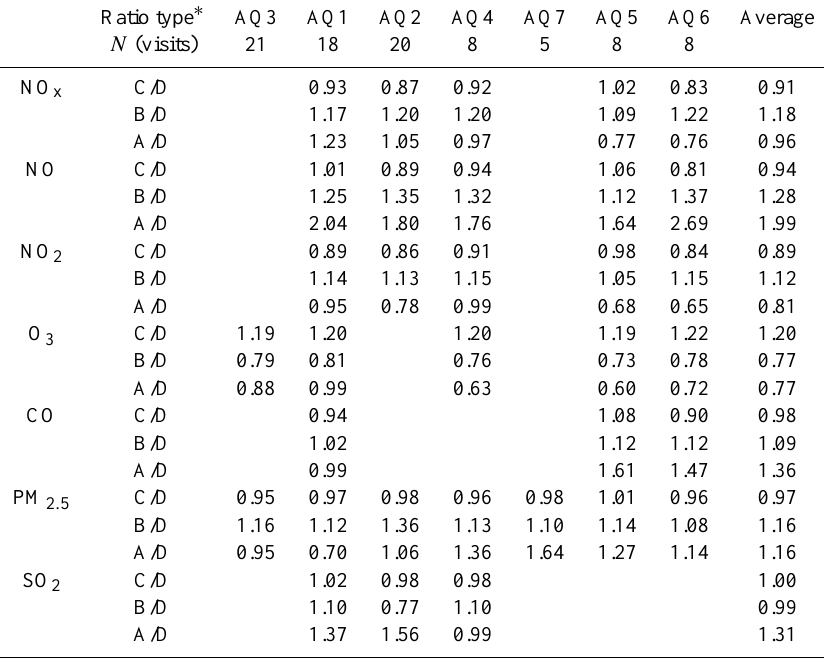
Table 2. Ratios between different average pollution levels shown in Figs. 2 and S1 in the